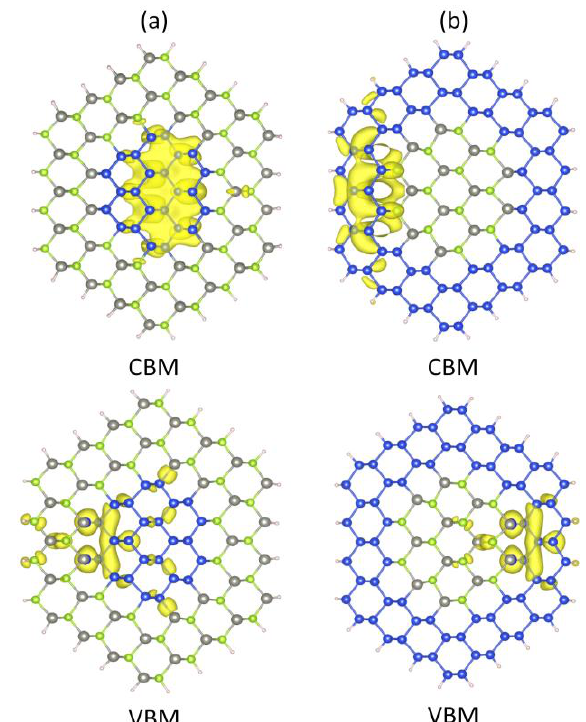
Figure 7. Partial charge density distribution of the CBM and VBM states of